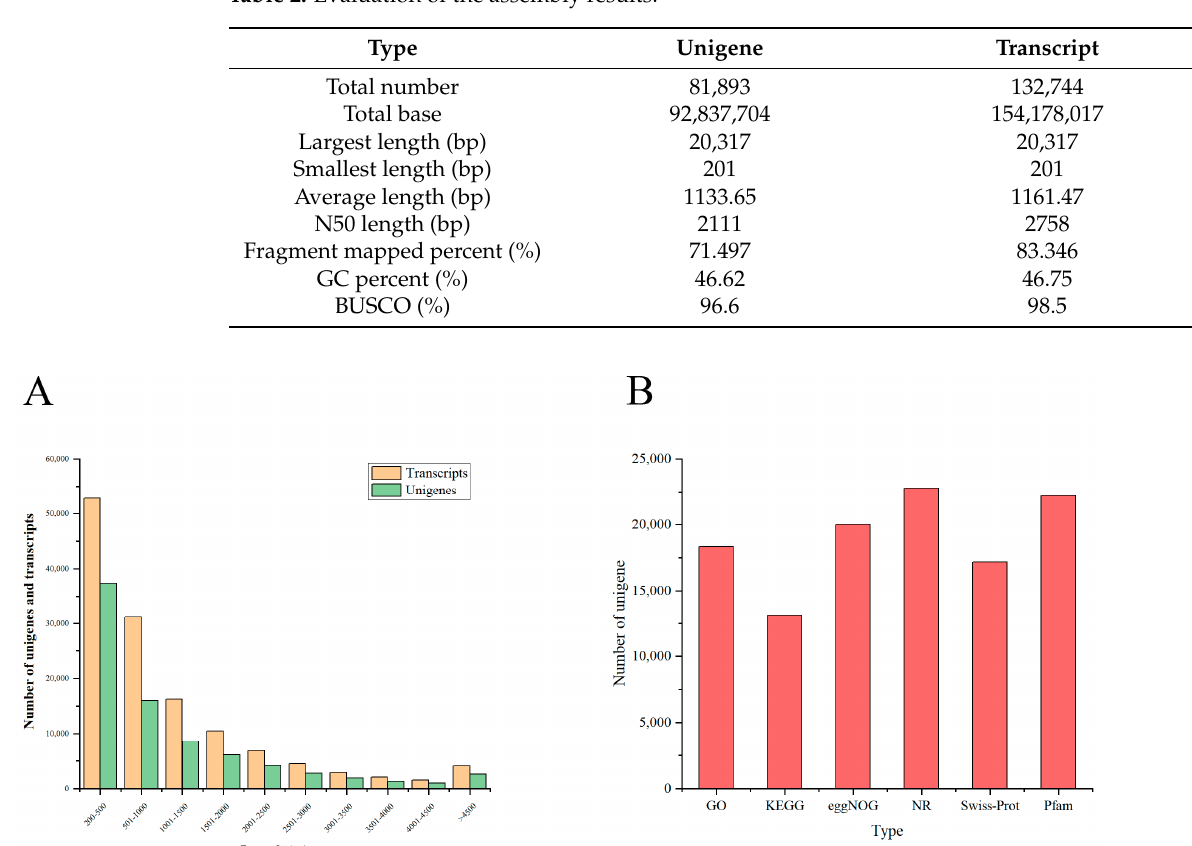
Table 2. Evaluation of the assembly results.